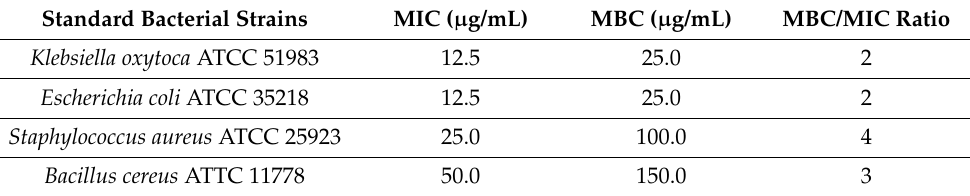
Table 2. The MIC values were determined by colorimetric assay (resazurin), MBC (99.9% kill) and MIC/MBC ratio of CMC-AgNPs against Klebsiella oxytoca , Escherichia coli , Staphylococcus aureus , and Bacillus cereus